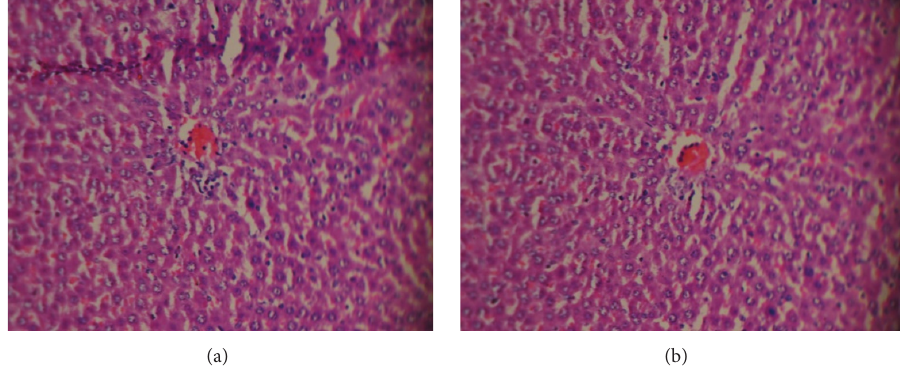
Figure 1: (a) Treated liver. (b) Control liver.